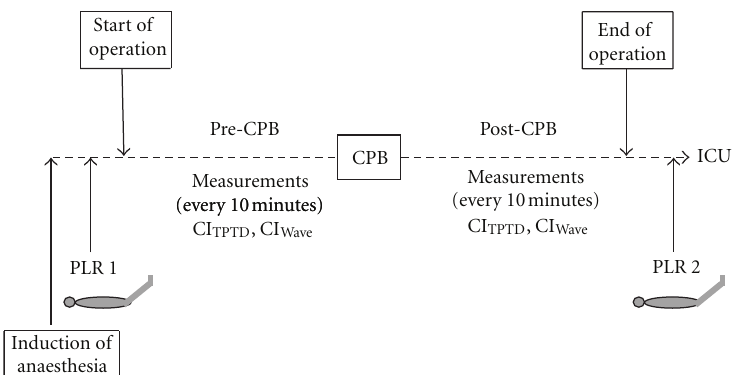
Figure 1: Study design. T1: data collection (CI Wave , CI TPTD ) after induction of anaesthesia and passive leg raising (PLR 1) until cardiopulmonary bypass; T2: data collection (CI Wave , CI TPTD ) after cardiopulmonary bypass until the end of surgery and passive leg raising (PLR